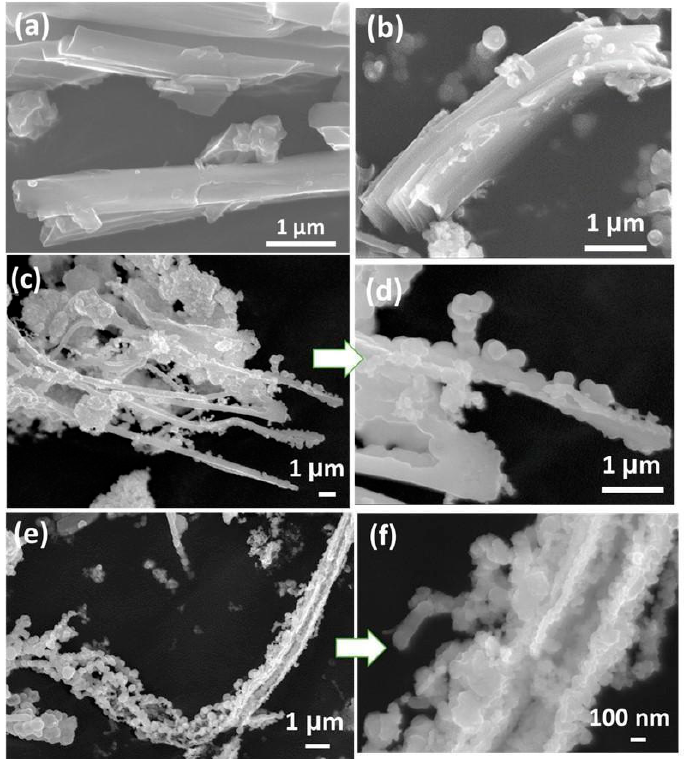
Figure 10. SEM micrographs of: ( a ) lightly ground commercial cobalt (II) acetate tetrahydrate sample, ( b ) elongated plates microcrystals of Co(II) oxyacetate Co 3 O(CH 3 COO) 4 , ( c ) cubic blende CoO polymorph at low magnification 7000× and ( d ) enlargement of ( c ), and ( e ) rocksalt CoO polymorph at (7,500×) and ( f ) at high-magnification (50,000×).